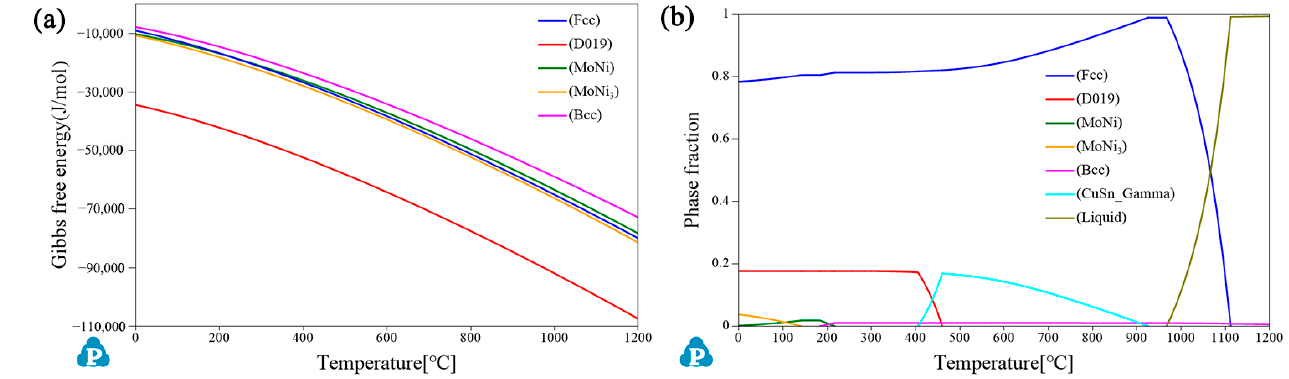
Figure 3. ( a ) Gibbs free energy diagram and ( b ) Phase fraction diagram at 1.5 wt.% Mo addition.